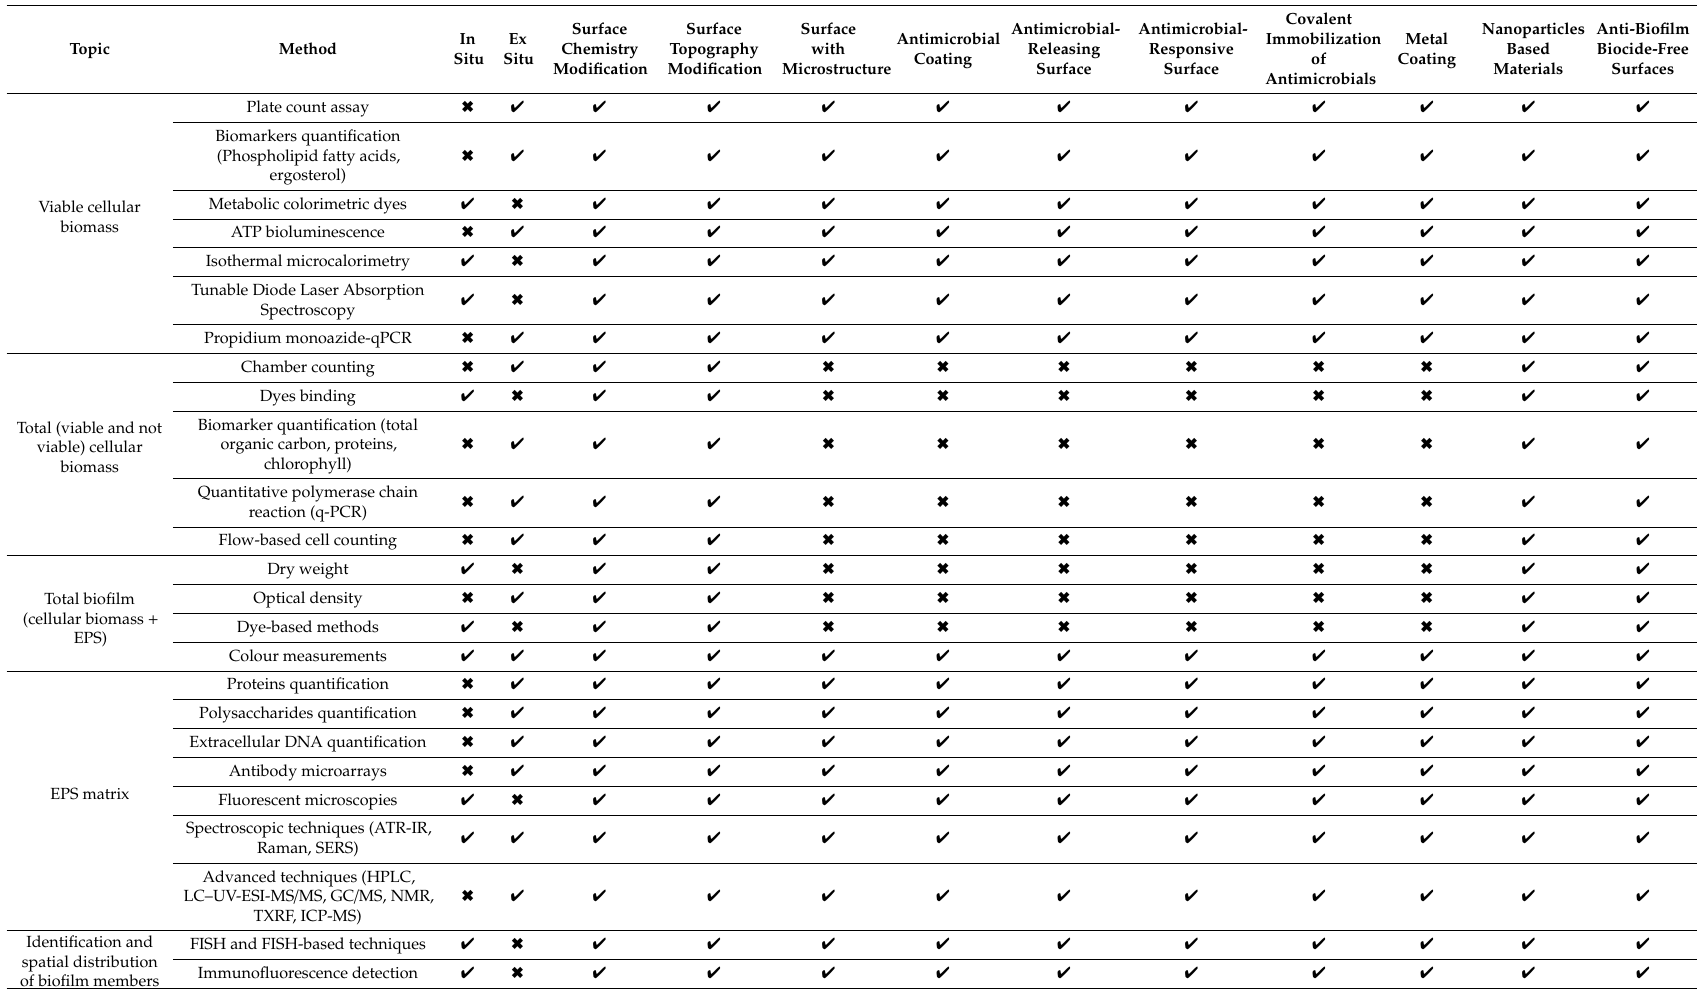
Table 2. Biofilm assays suitable for the main categories of anti-biofilm surfaces. The anti-biofilm surfaces are categorized according to Catt ò et al.